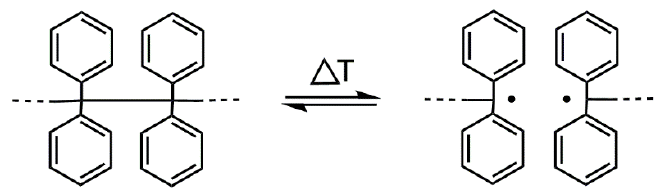
Figure 1. Reversible thermal dissociation of the TPE